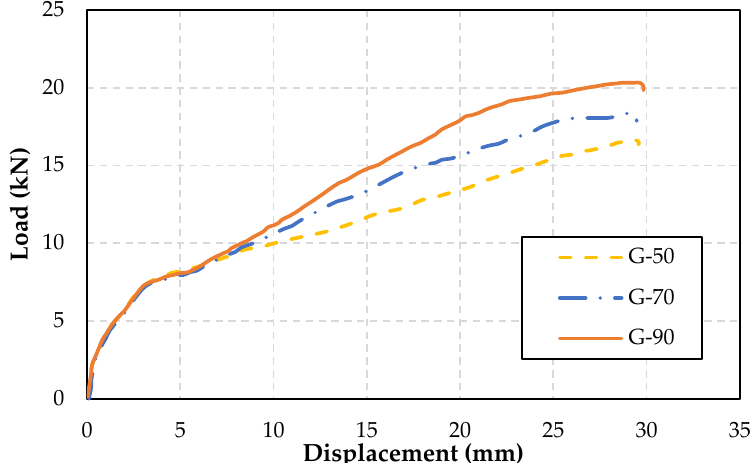
Figure 8. Effect of concrete compressive strength on the behavior of CFRP-strengthened slabs.